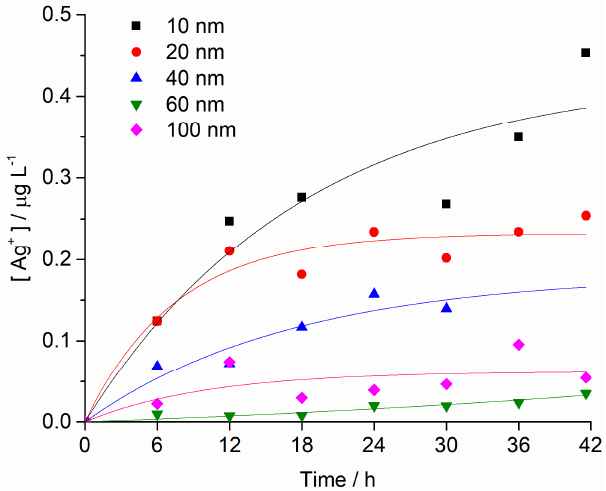
Figure 3. Concentrations of Ag + ions as a function of time for all AgNP sizes in FSW (initial AgNP conc. 1 mg L − 1 ). Each sample was measured twice, and RSD values were <5%.